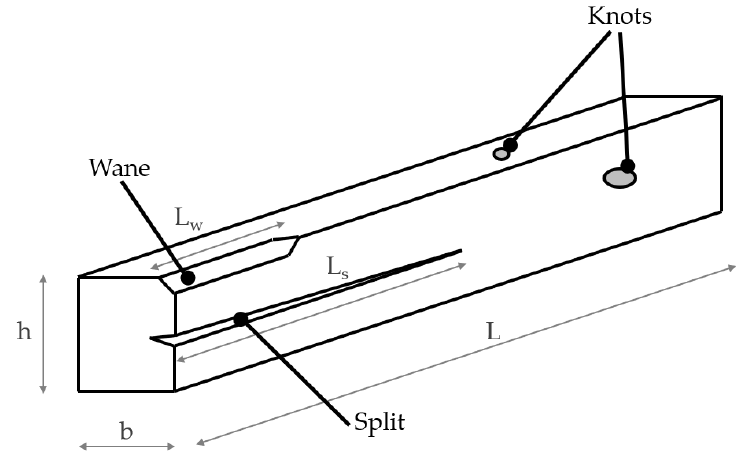
Figure 12. Most important defects in solid timber: knots, wanes and splits.